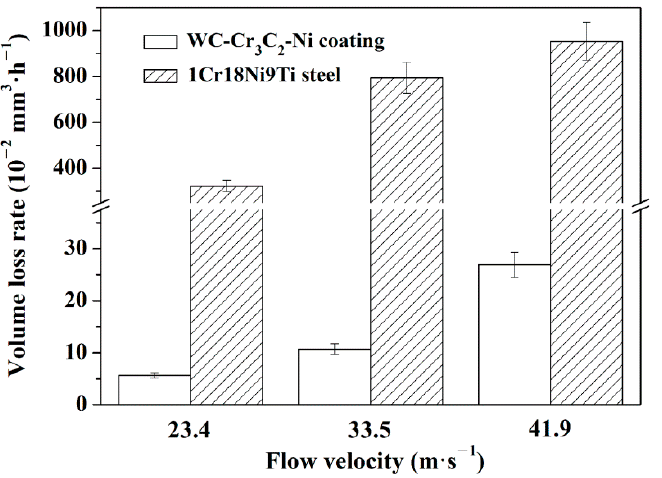
Figure 7. Volume loss rates of the WC-Cr 3 C 2 -Ni coating and the 1Cr18Ni9Ti stainless steel after CSE for 6 h in 3.5 wt.% SCM at 20 kg · m − 3 and different FVs.